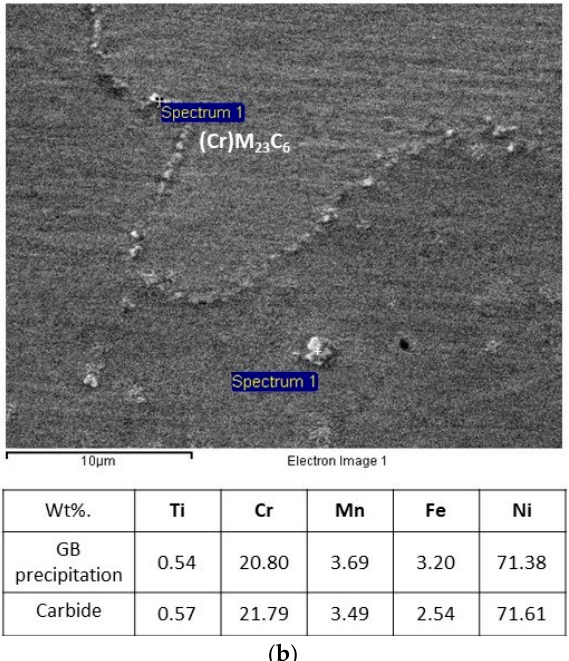
Figure 16. Typical morphology of precipitates distribution of Alloy 800H: ( a ) BM and ( b ) weldments. LCF ‐ HT test at 0.6% total strain range.